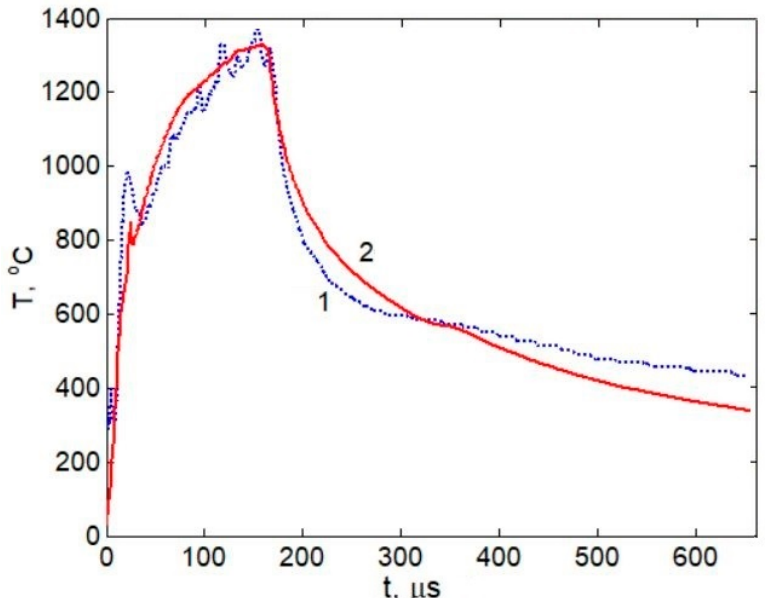
Figure 11. Time variations of the measured (curve 1) and calculated surface temperature (curve 2) for the silumin sample with a 1- μ m coating.